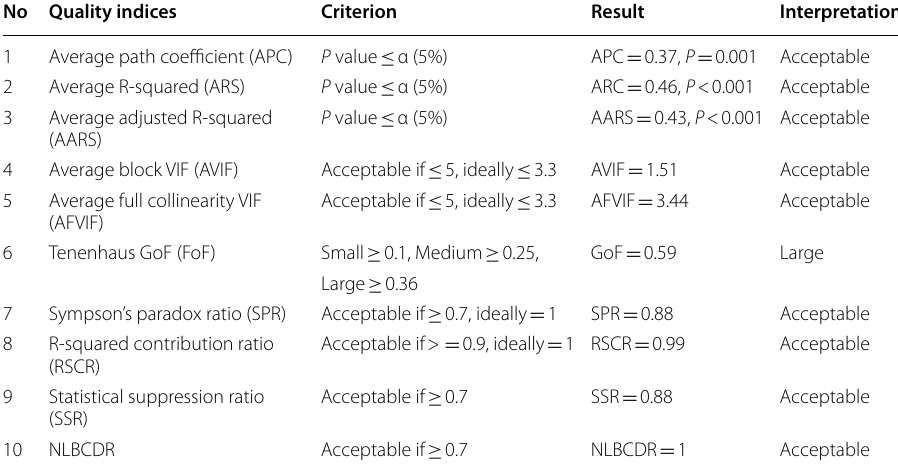
Table 1 Model fit and quality